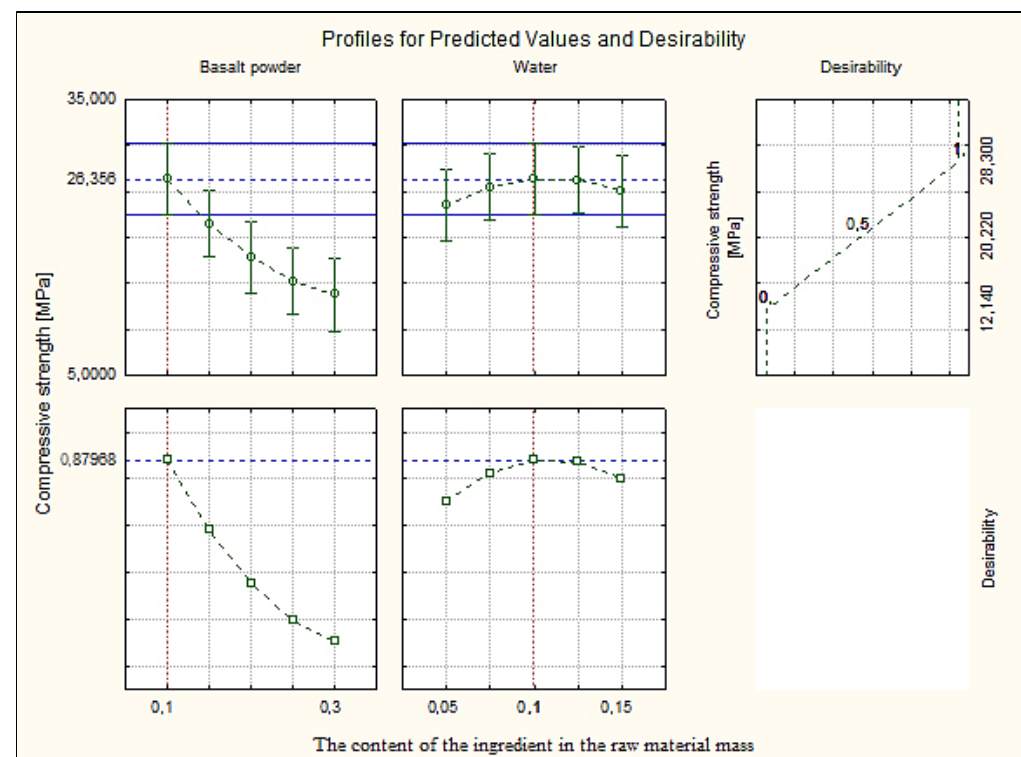
Figure 17. Profiles for predicted value and desirability for compressive strength.